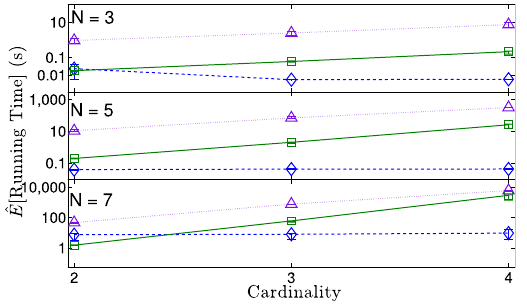
Figure 8. The expected running time for different methods at different variable cardinalities, and number of variables, N . The three methods are: our linear optimization method conditioned on mutual informations and univariate entropies (blue diamonds and dashed line); iterative fitting conditioned on the bivariate distributions (green squares and solid line); iterative fitting conditioned on the first two moments (purple triangles and dotted line). For each cardinality and N , the distributions and error calculations are the same as for Fig.